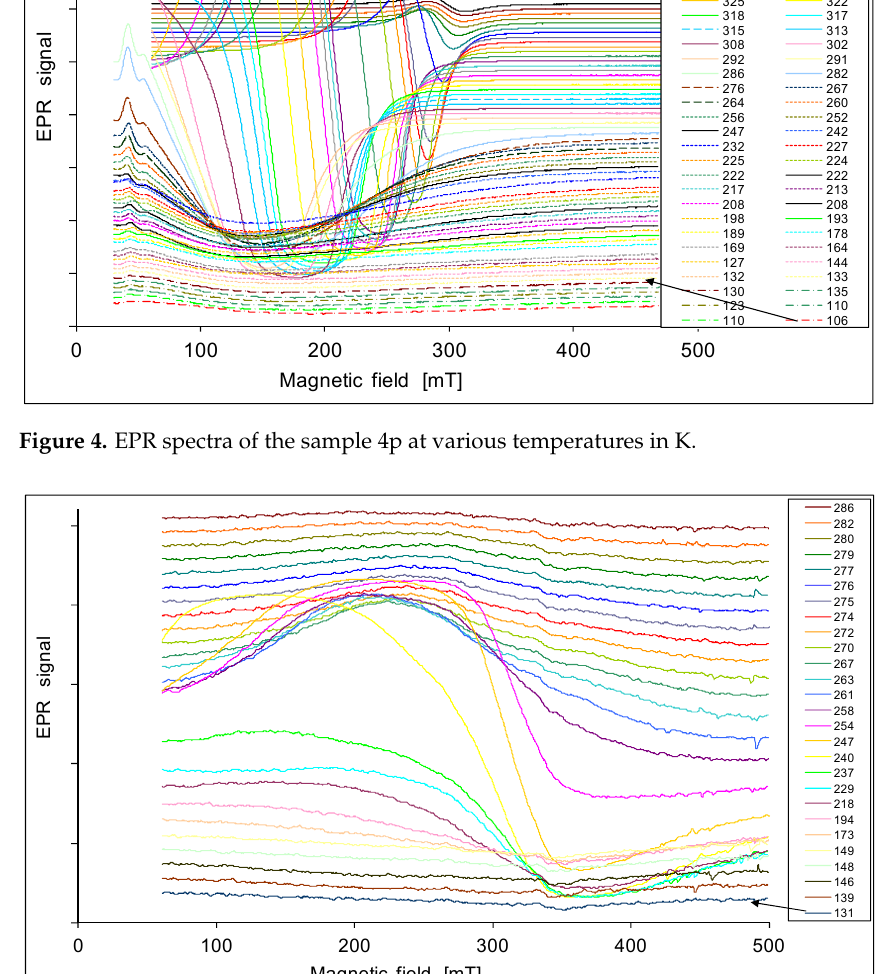
Figure 5. EPR spectra of the sample 5p at various temperatures in K.